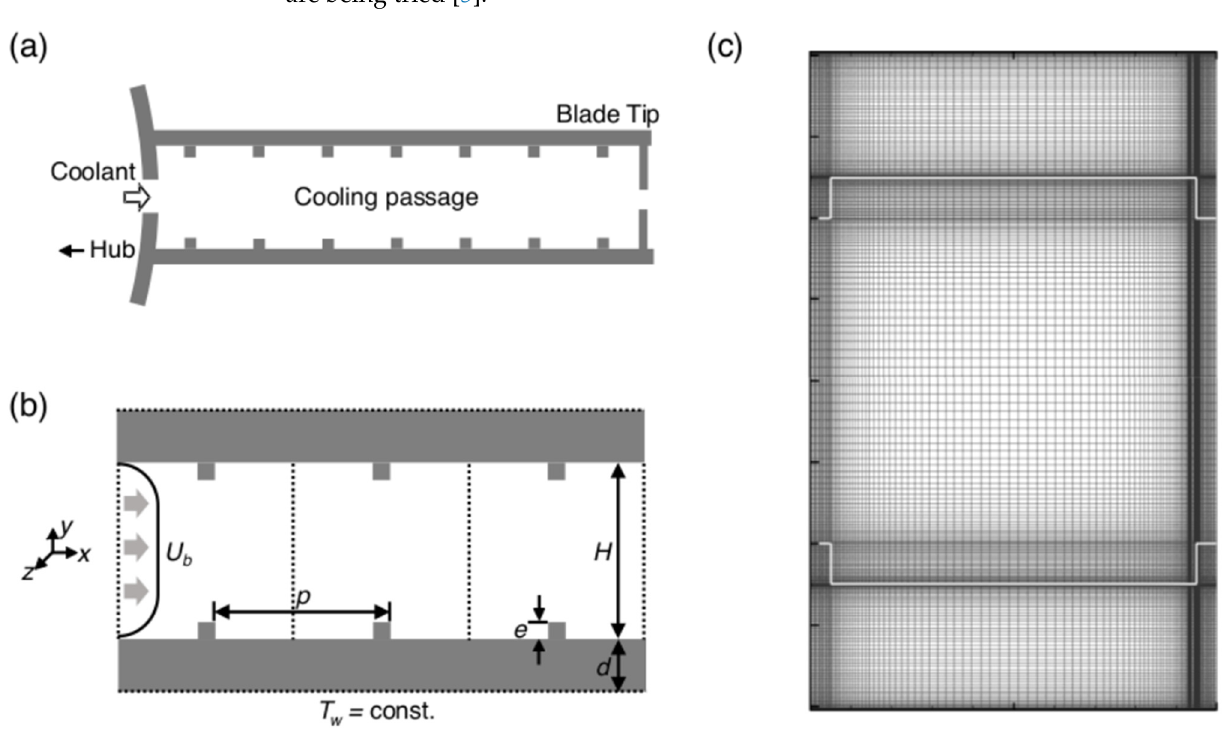
Figure 1. Computational domain and grid system: ( a ) schematic of the internal cooling passage; ( b ) computational domain; and ( c ) grid system.